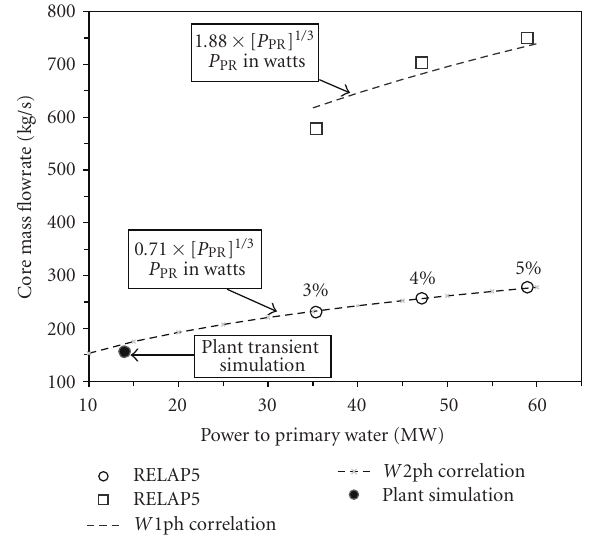
Figure 11: One-phase and maximum two-phase flowrate as a func- tion of the power delivered to water (following Du ff ey and Sursock,